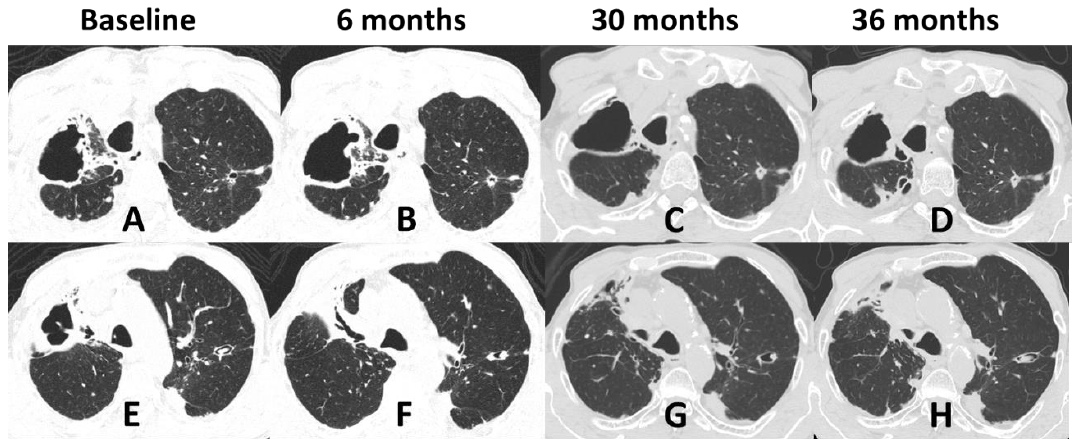
Figure 4. Nonenhanced chest computed tomography of a 63-year-old man with disseminated sporotrichosis and lung lesions, at four moments (Case 2). ( A , E ) At the beginning of treatment for sporotrichosis. ( B , F ) Six months of treatment. ( C , G ) At 30 months of treatment. ( D , H ) At 36 months of treatment. Among many alterations, there is a thick-walled cavity with irregular margins in the right lower lobe, associated with architectural distortion, fibrotic opacities, and traction bronchiectasis. There is also bronchiectasis in the apicoposterior segment of the left upper lobe, some filled by fluid density material, suggestive of mucous plugging. Areas of pleural thickening in the upper third of the lungs. Images A to D and E to H are similar sections over time.